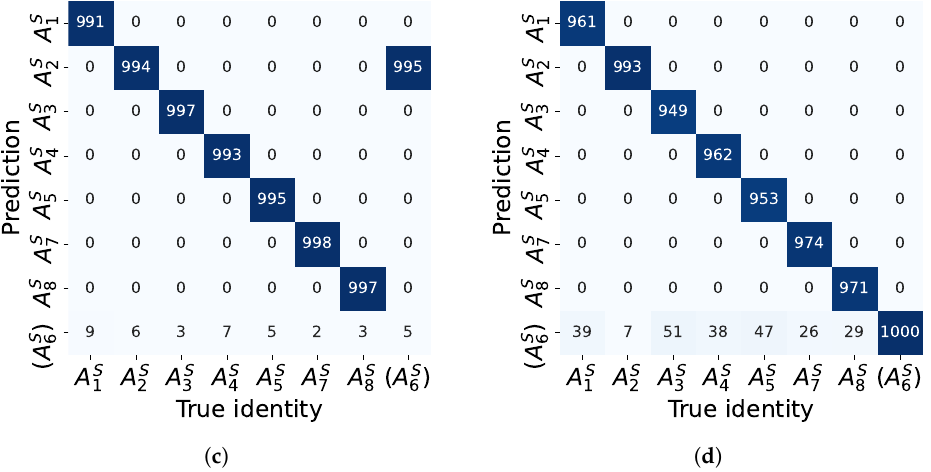
is in brackets to denote that it is 6